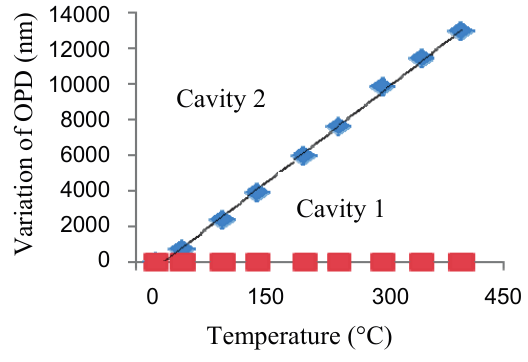
Figure 6. Variation of OPDs with temperature.